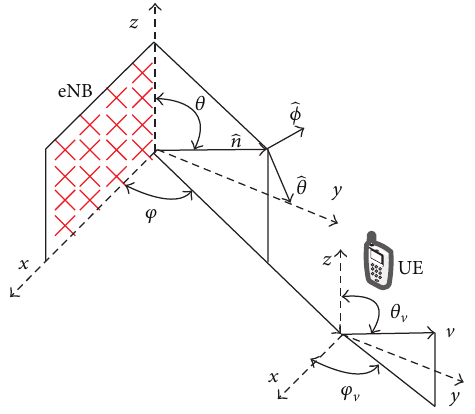
Figure 5: Illustration of coordinate [11,